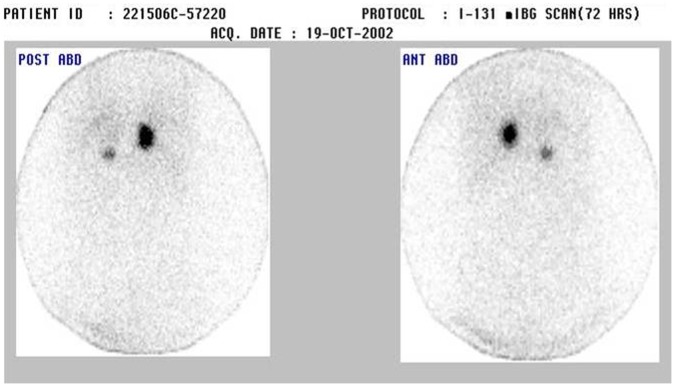
MIBG scan showing bilateral adrenal tumors.